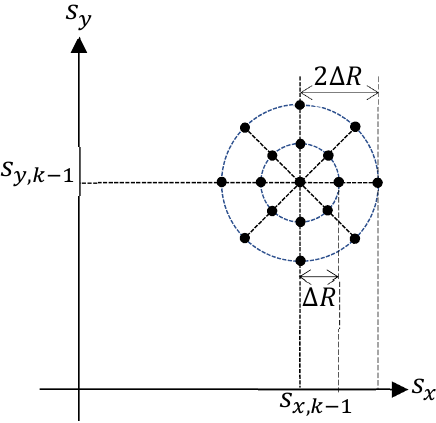
Figure 7. All the admissible movements of a sensor with parameters N R = 2 and N θ = 8 are shown as solid black circles.